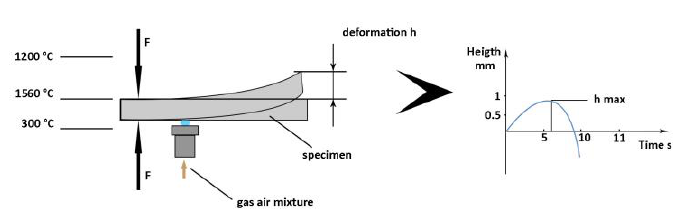
Figure 5. Scheme and principle of the HD (High Distortion) test [1].